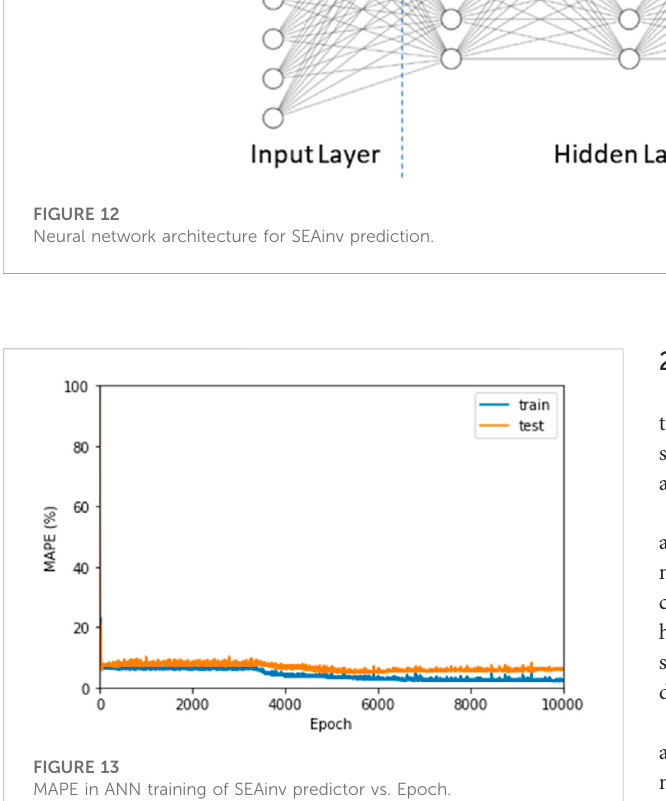
MAPE in ANN training of SEAinv predictor vs.